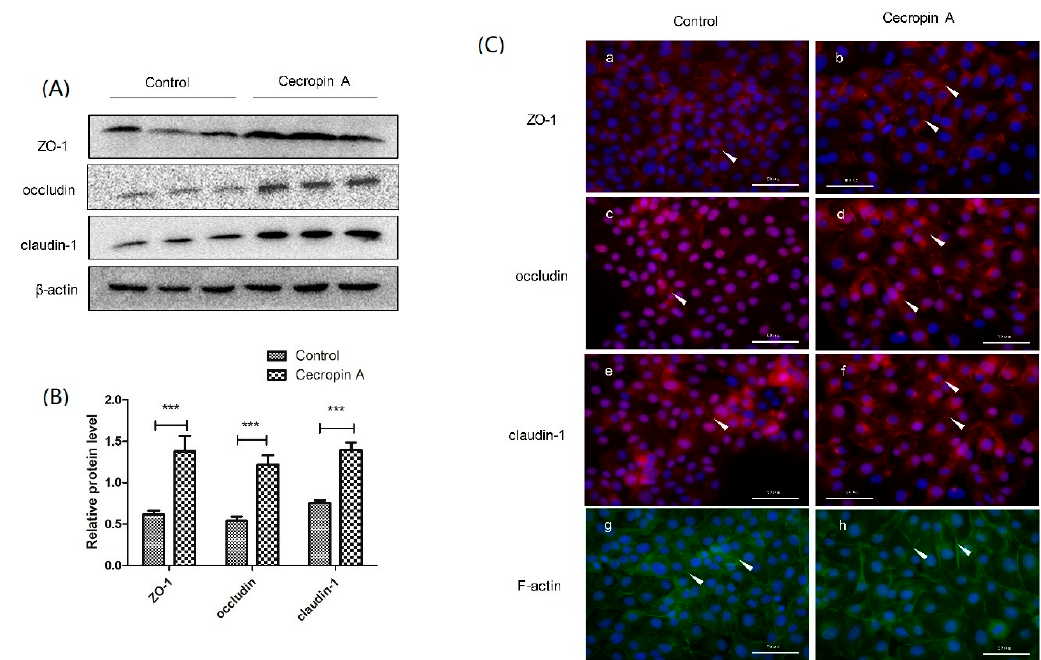
Figure 3. The effect of cecropin A on tight junction (TJ) protein expression, membrane distribution and F-actin polymerization. Western blotting analysis of zonula occludens-1 (ZO-1), occludin and claudin-1 expression were upregulated by cecropin A treatment (( A ), n = 3); quantification of ZO-1, occludin, and claudin-1 protein expression was shown (( B ), n = 3); cell immunofluorescence ( C ) (400×) showed that the cecropin A induced the TJs polymerized at the cell–cell boundary ( a – f ) and indicated F-actin polymerization ( g , h ) in cells (( c ), n = 3). The results were confirmed by three independent experiments per treatment. Representative results of the three independent experiments are shown. Data (mean ± SEM) were analyzed with the Student’s t -test. Cell nuclei were stained by 4’,6- Diamidino-2-phenylindole dihydrochloride (DAPI) and are shown in blue. Claudin-1, ZO-1 and occludin are shown in red and pointed out by white arrow heads. F-actin is shown in green. Scale bar is 50 μ m. *** p < 0.001.